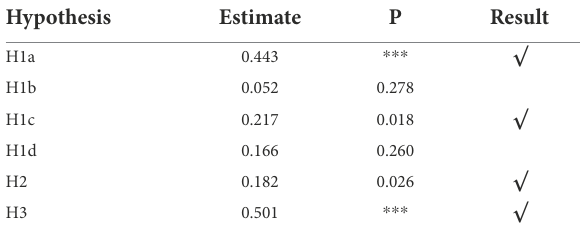
TABLE 6 Initial hypothesis test.